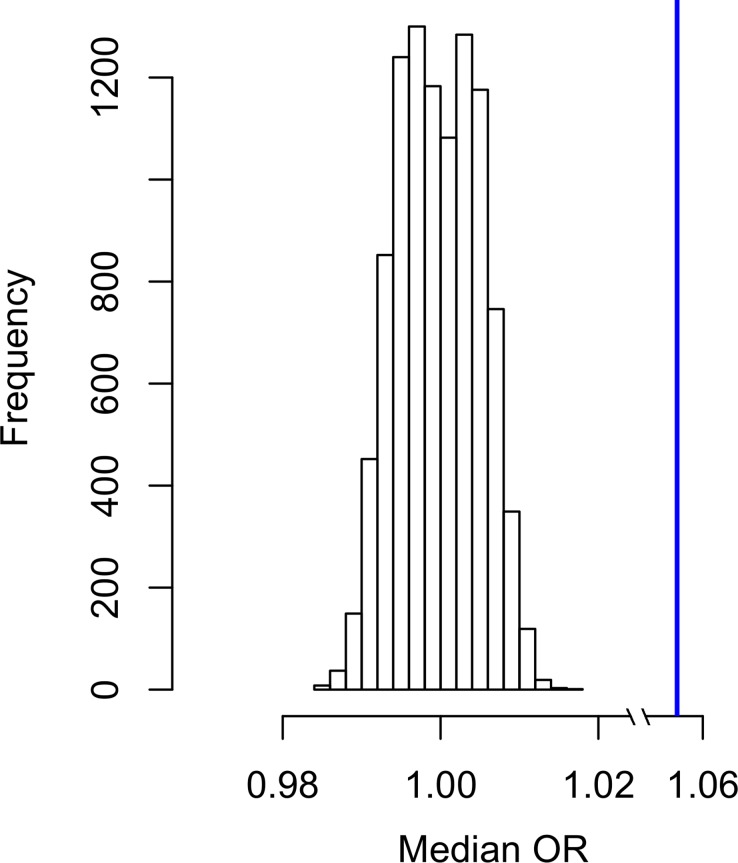
Null distribution of median OR (considering minor allele effect) generated from 10,000 permutations of ASD dataset.Blue line represents the median OR observed in the actual ASD dataset.